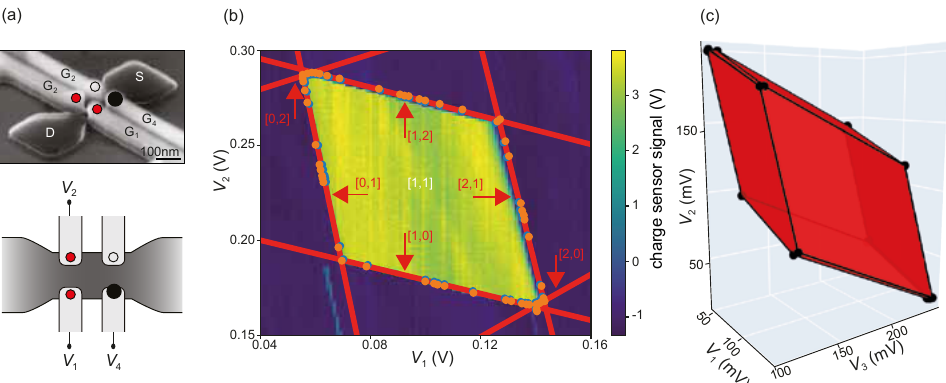
Figure 1. Automatic discovery algorithm implemented on a real quantum dot array with a sensor dot coupled to either a double dot or a triple dot. ( a ) Micrograph of the device. Individual electrons originating from the source (S) or drain (D) reservoirs can be trapped by gate-induced quantum dots (circles), located below electrostatic gate electrodes G 1,...,4 and controlled by voltages V 1,...,4 . For the targeted [ 1,1 ] state, each qubit dot (red) contains one electron, whereas the sensor dot (black) is used to generate a high bandwidth sensor signal. ( b ) 2D map of the sensor signal as a function of the control voltages V 1 and V 2 , acquired in high resolution to illustrate the convex polytope of this device configuration. For all yellow pixels, the qubit array is in the [ 1,1 ] state. (Whenever V 1,...,3 is changed, V 4 is not held constant but compensates the sensor dot potential for capacitive cross talk from G 1 , G 2 and G 3 , see experiments.) Our algorithm estimates state transitions to other states (red lines), based on a small number of point pairs ( x + , x − ) (blue and orange dots) obtained via line searches. Target states of transitions are annotated by [ x , y ] . ( c ) Estimated state boundaries of the 3D polytope associated with single-electron occupation of three quantum dots (under G 1 , G 2 and G 3 ). The ground truth of this triple-dot system is already tedious to measure and unknown for this device